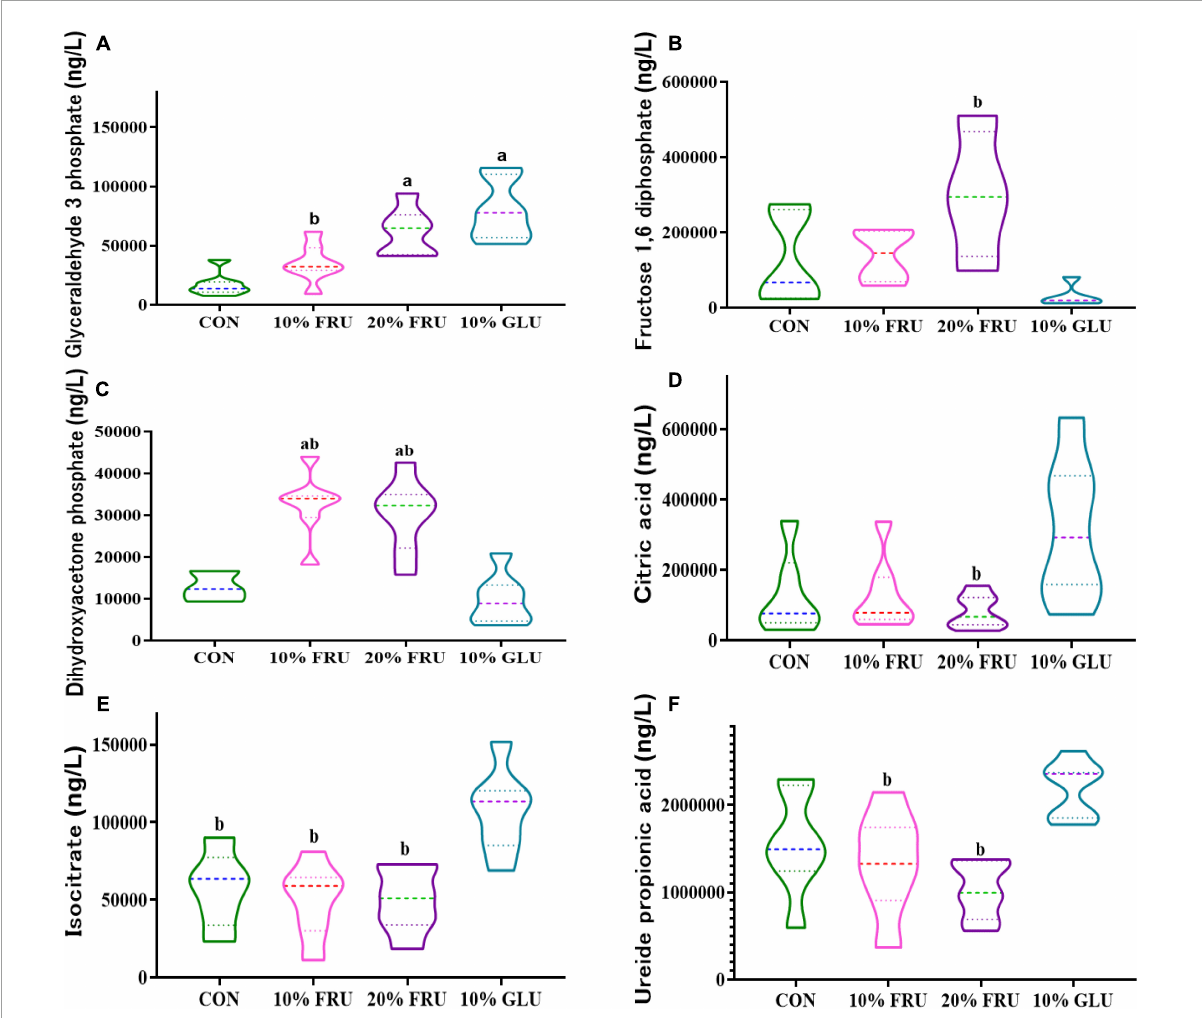
FIGURE5 Effects of excessive fructose intake on the metabolites of central carbon metabolism in rats: (A) glyceraldehyde-3-phosphate, (B) fructose-1,6-diphosphate, (C) dihydroxyacetone phosphate, (D) citric acid, (E) isocitrate, and (F) ureide propionic acid. The values were presented as mean ± SD ( n = 7); a means p < 0.05 compared with the CON group and b means p < 0.05 compared with the 10% GLU